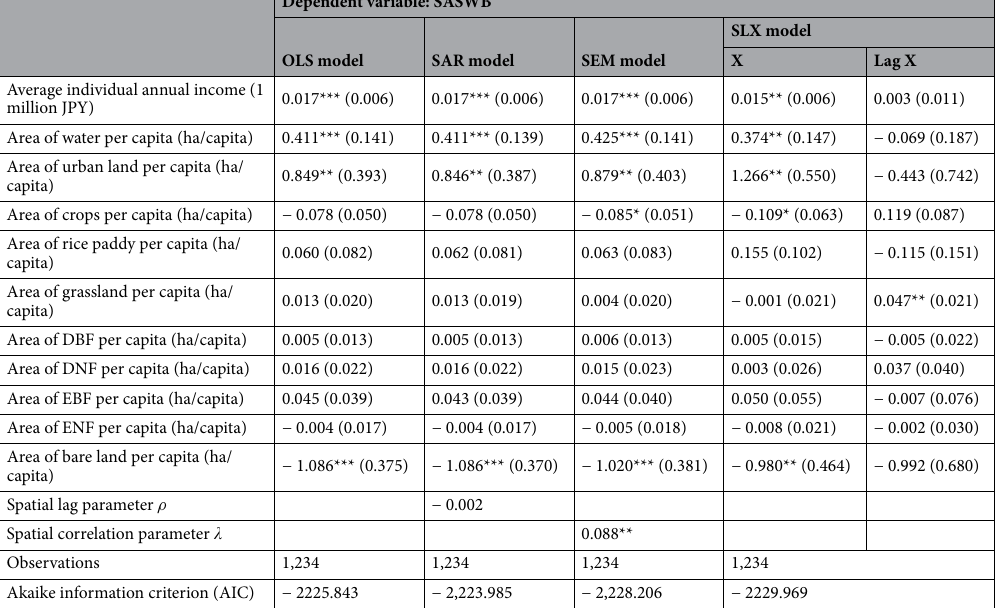
Table 1. Partial regressions results. X in the SLX model represents the variables of sub-prefecture regions themselves, while Lag X represents the variables of their neighbors. (Full regressions results are shown in Table S3). *p < 0.1, **p < 0.05, ***p <